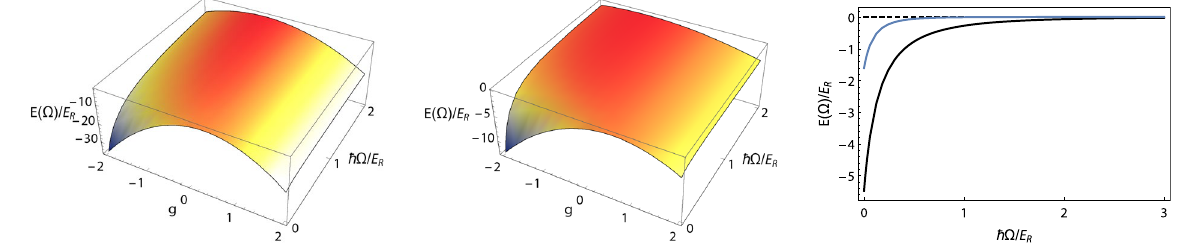
Figure 4. Raman controlled effective interaction between two impurity atoms: Δ E Ram ( d , Ω) as function of the Raman laser coupling ħ Ω and of the ratio of the impurity-BEC coupling constants = g g g / Aab Bab ( ) ( ) and = g g 10 Bab AAab ( ) ( ) . The Raman strength is in recoil energy units. The relative distance d = | x impurities is fixed to d = 0 (left), d = a (centre), where a = λ /2 is the lattice spacing. (right) Δ E Ram ( d , Ω), respectively for d = a (black line) and d = 2 a (blue line)with g = − 1, as a function of the Raman coupling strength.